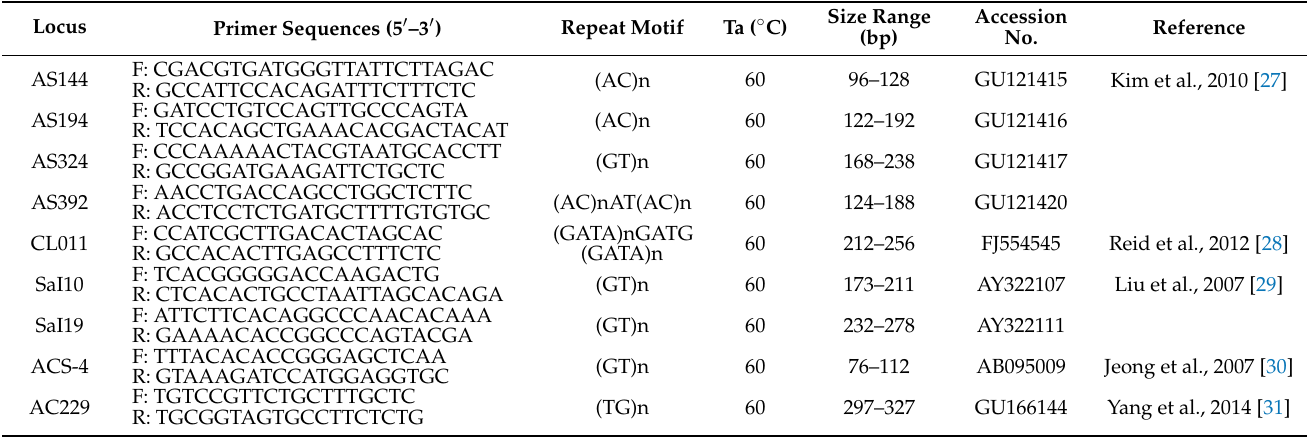
Table 2. Nine selected microsatellite loci of black sea